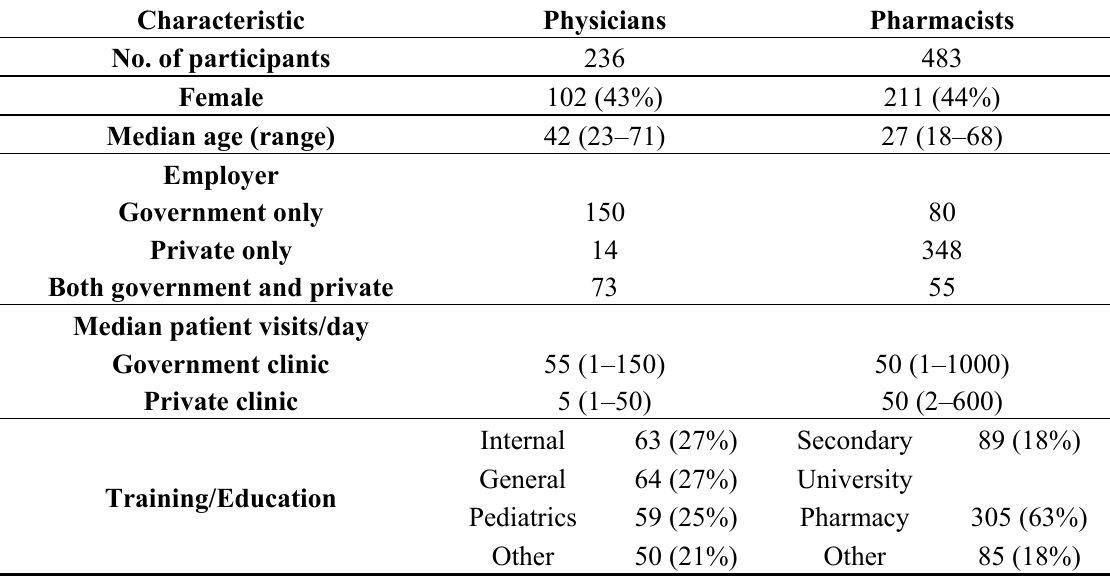
Table 1. Characteristics of physicians and pharmacists, Minya District, Egypt, 2011.